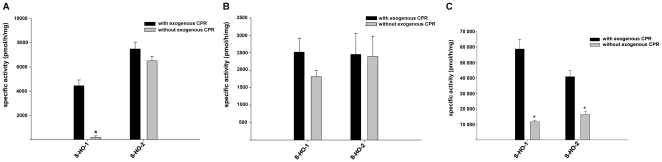
Comparison of enzyme activity of full-length HO isoforms.Measurements were made in the presence (black columns) and absence (grey columns) of exogenous CPR. (A) HO activity measured in cytosolic fractions from Sf9 cells expressing the indicated HO variants. (B) Same experiments made in homogenates from Sf9 cells. (C) Enzyme activity assay after purification using the Strep-tag/Streptavidin system. Data are shown as means ± SEM (n = 3, *p<0.05).